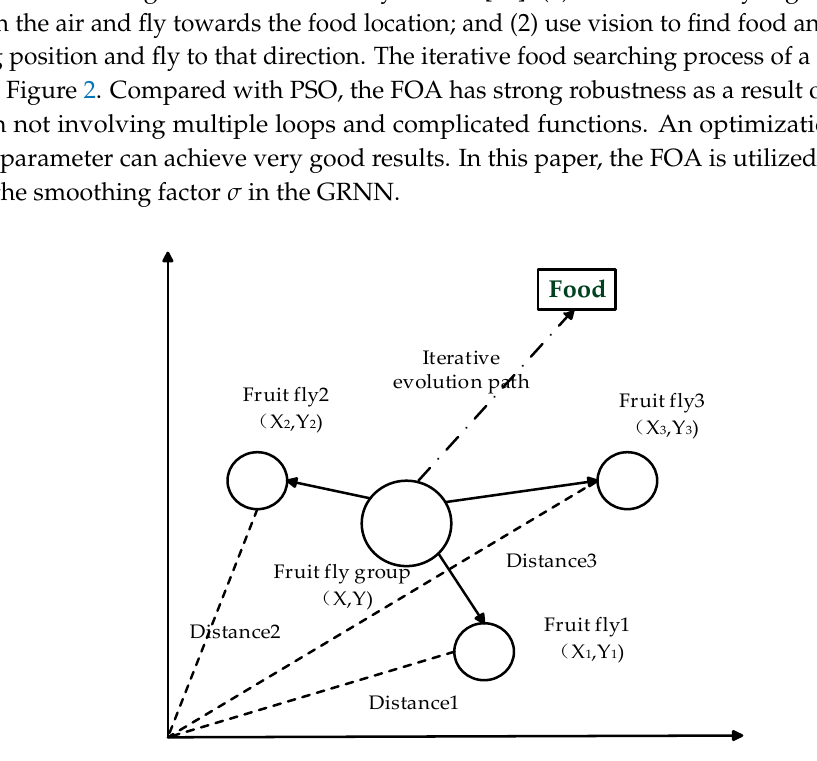
Figure 2. Iterative food searching process of a fruit fly swarm.